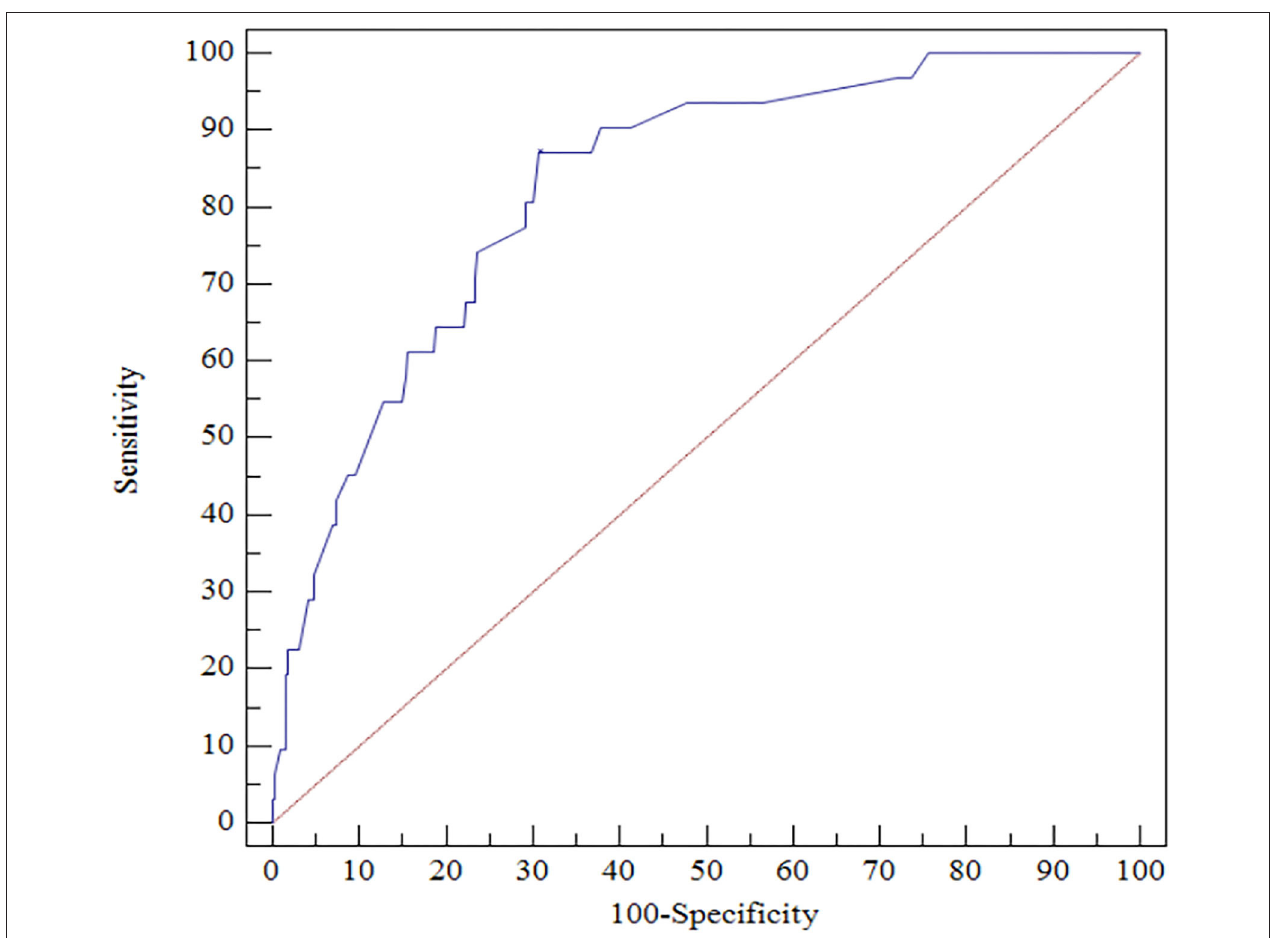
FIGURE 3 | ROC curves for CRP predicting 1-year all-cause death.